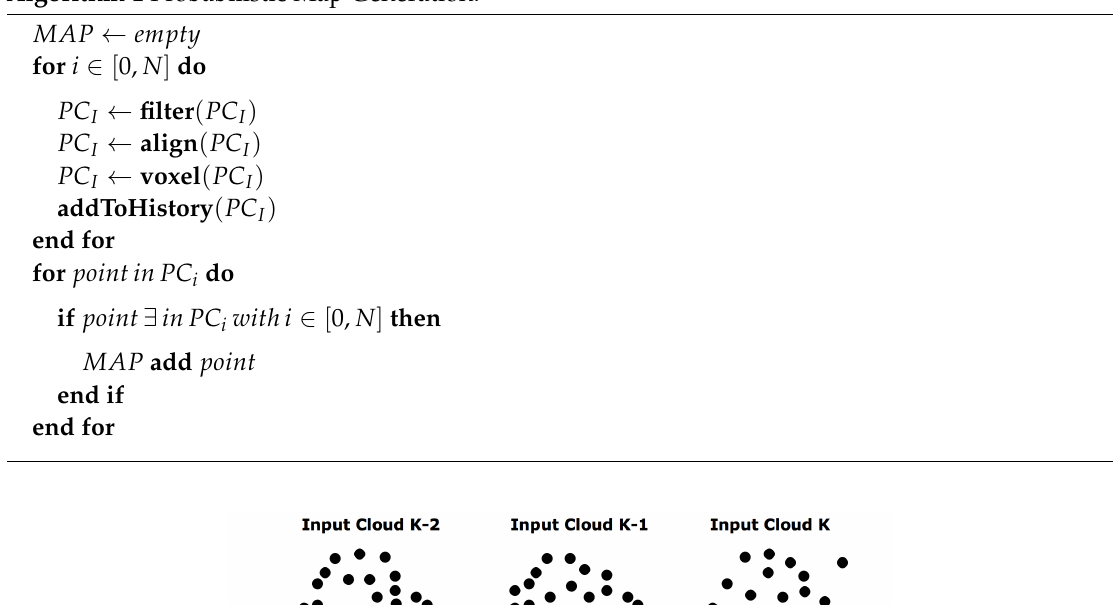
Algorithm 1 Probabilistic Map Generation.